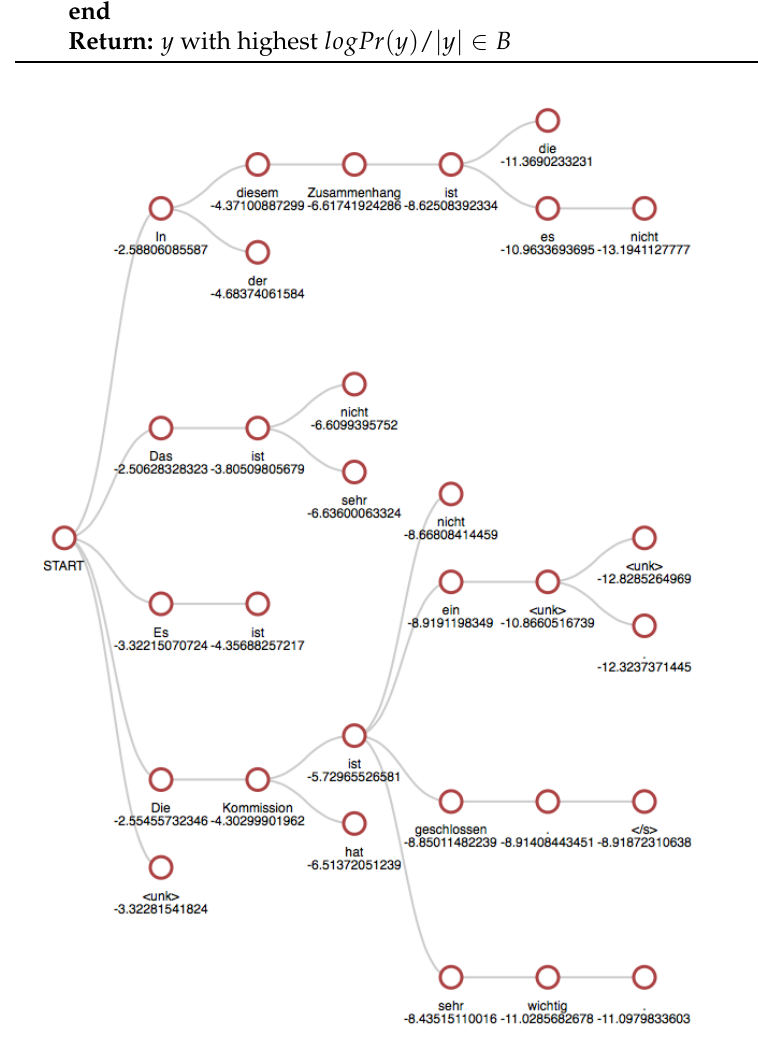
Figure 1. Visualization of beam search, example taken from